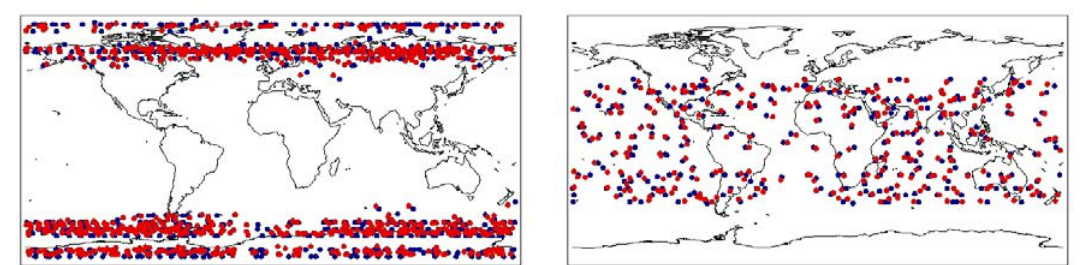
Figure 1 . MIPAS2D (red) and ACE-FTS (blue) geolocations of the coincidences for the polar (830 collocations, left panel) and the trp-midlat (260 collocations, right panel) regions. compared: coincidence criteria were determined on the basis of spatial (by distance) and time limits.